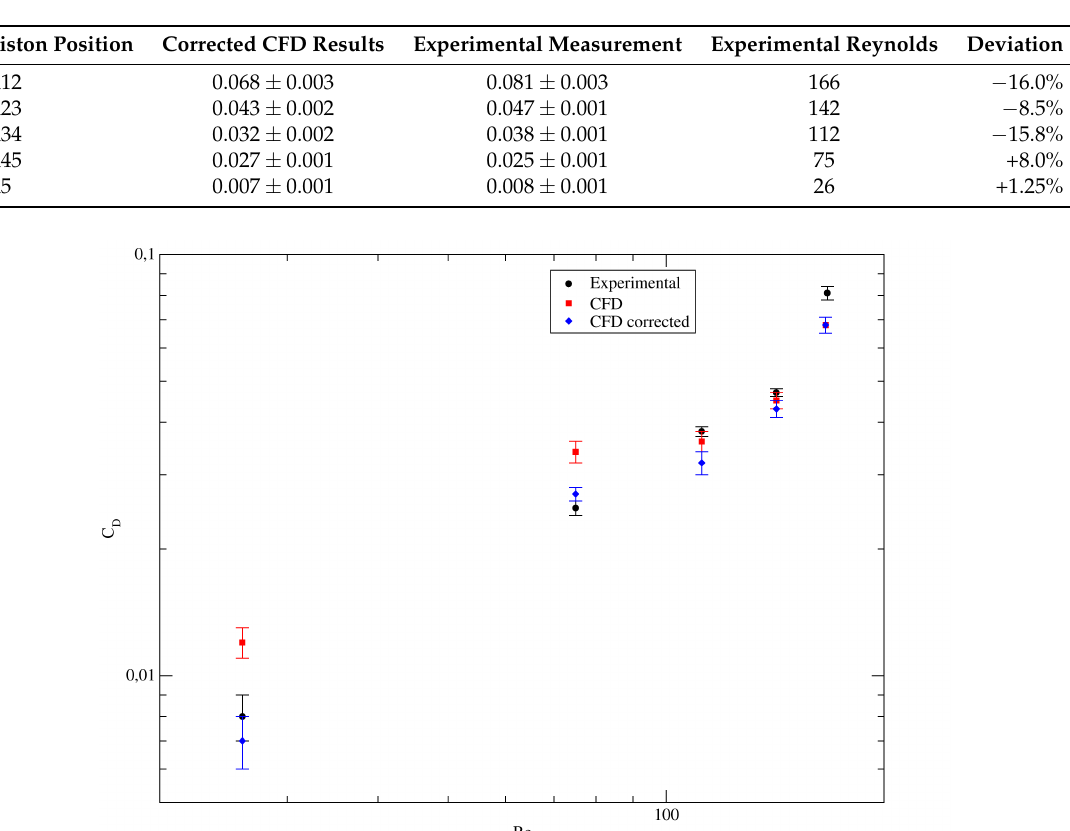
off-centered piston.